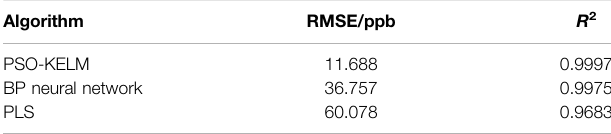
TABLE 1 | Comparison of fi tting precision of BP neural network, PLS, and PSO- KELM algorithms for the step test of N 2 O gas. Algorithm